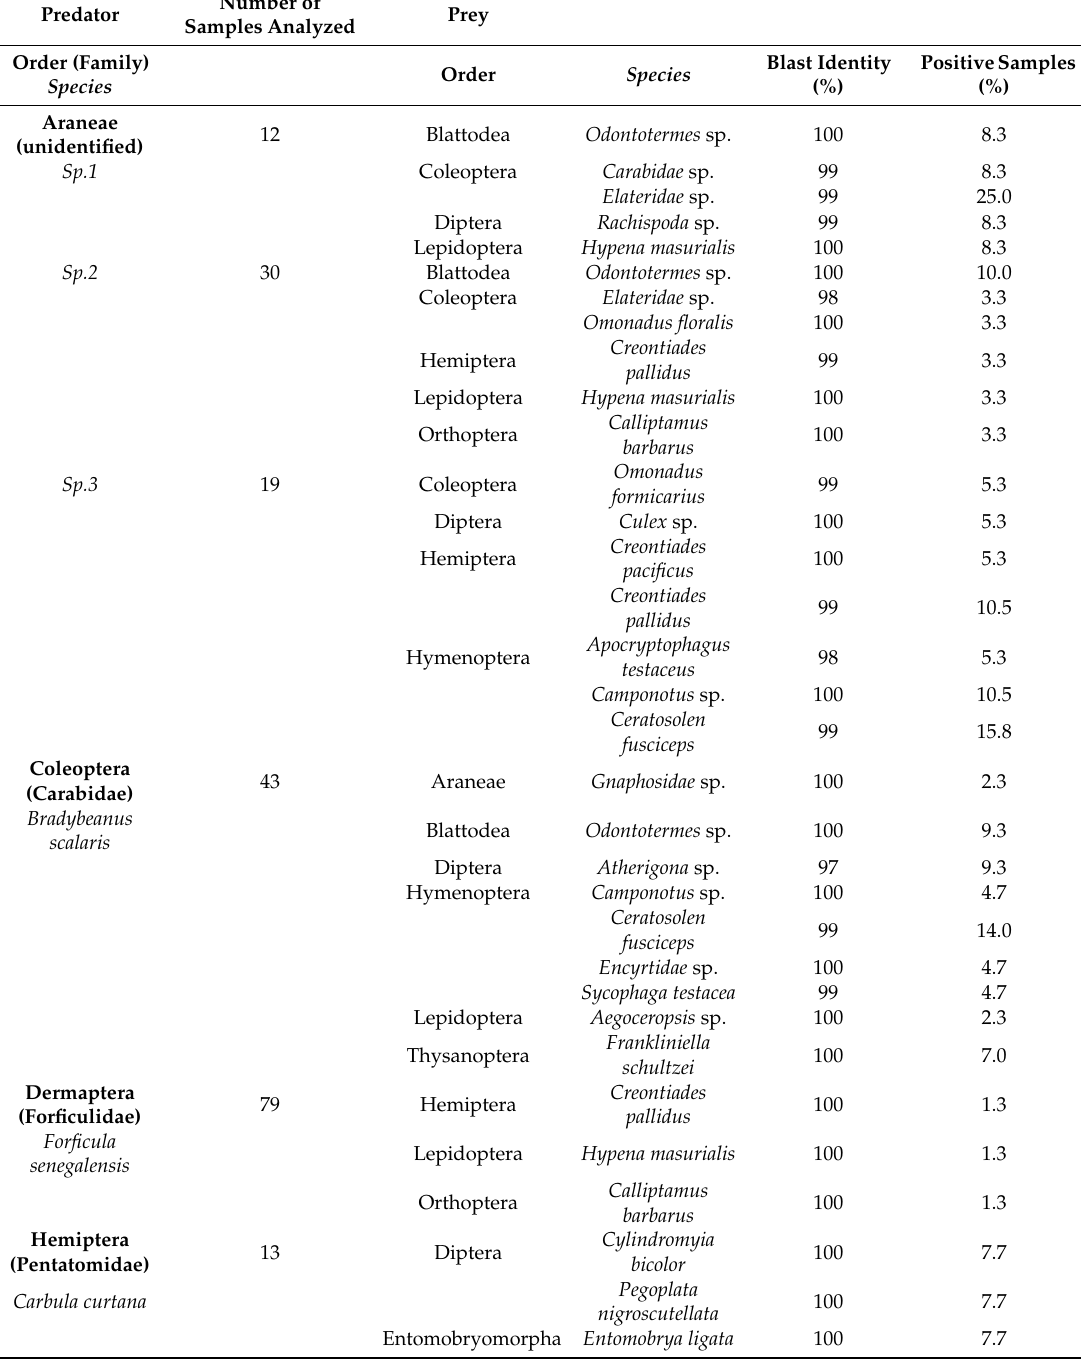
Table 1. Taxa and number of positive samples of prey species detected from nine arthropod predator taxa ( n = 256) collected from millet fields in